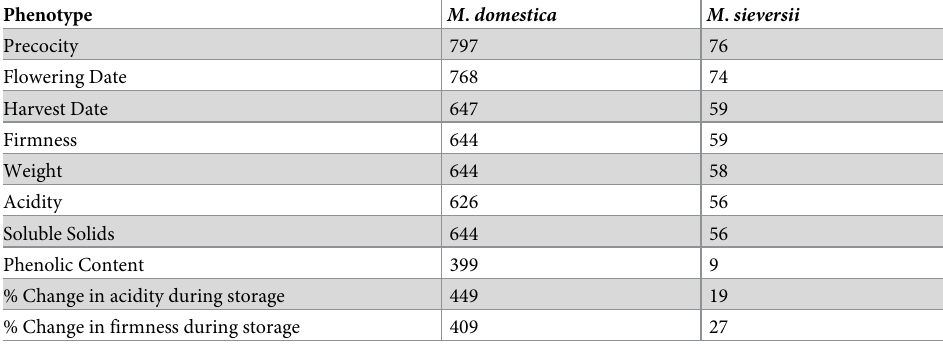
Table 1. Sample sizes by